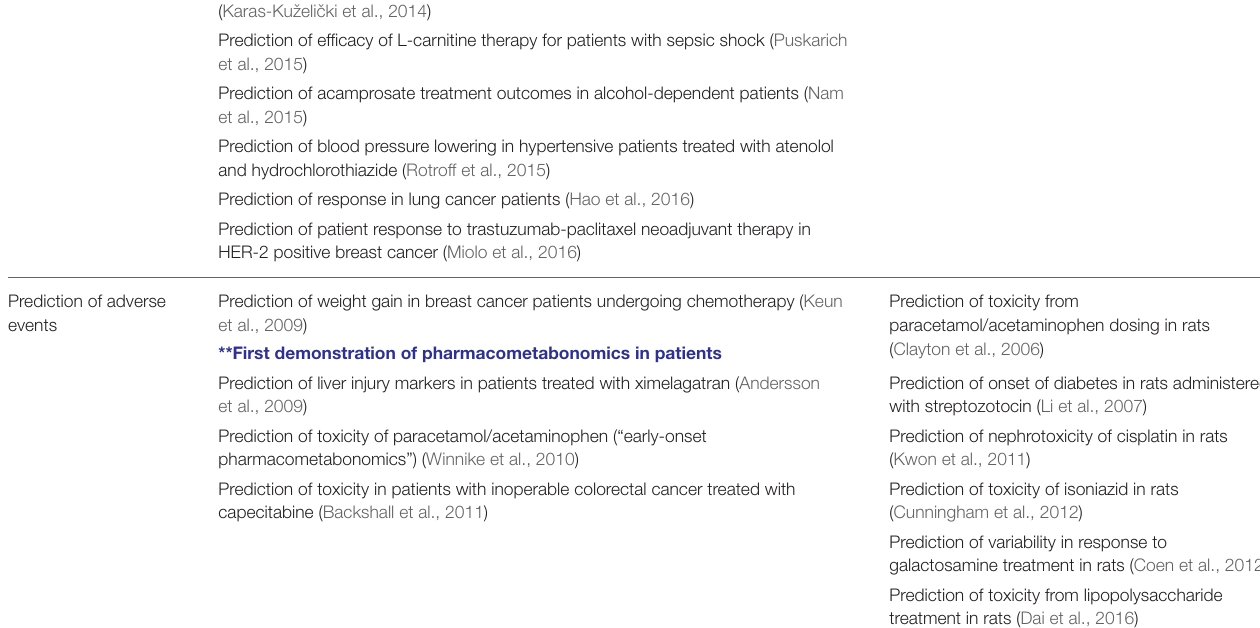
a Significant papers are highlighted with a double asterisk with explanatory text in bold blue font.